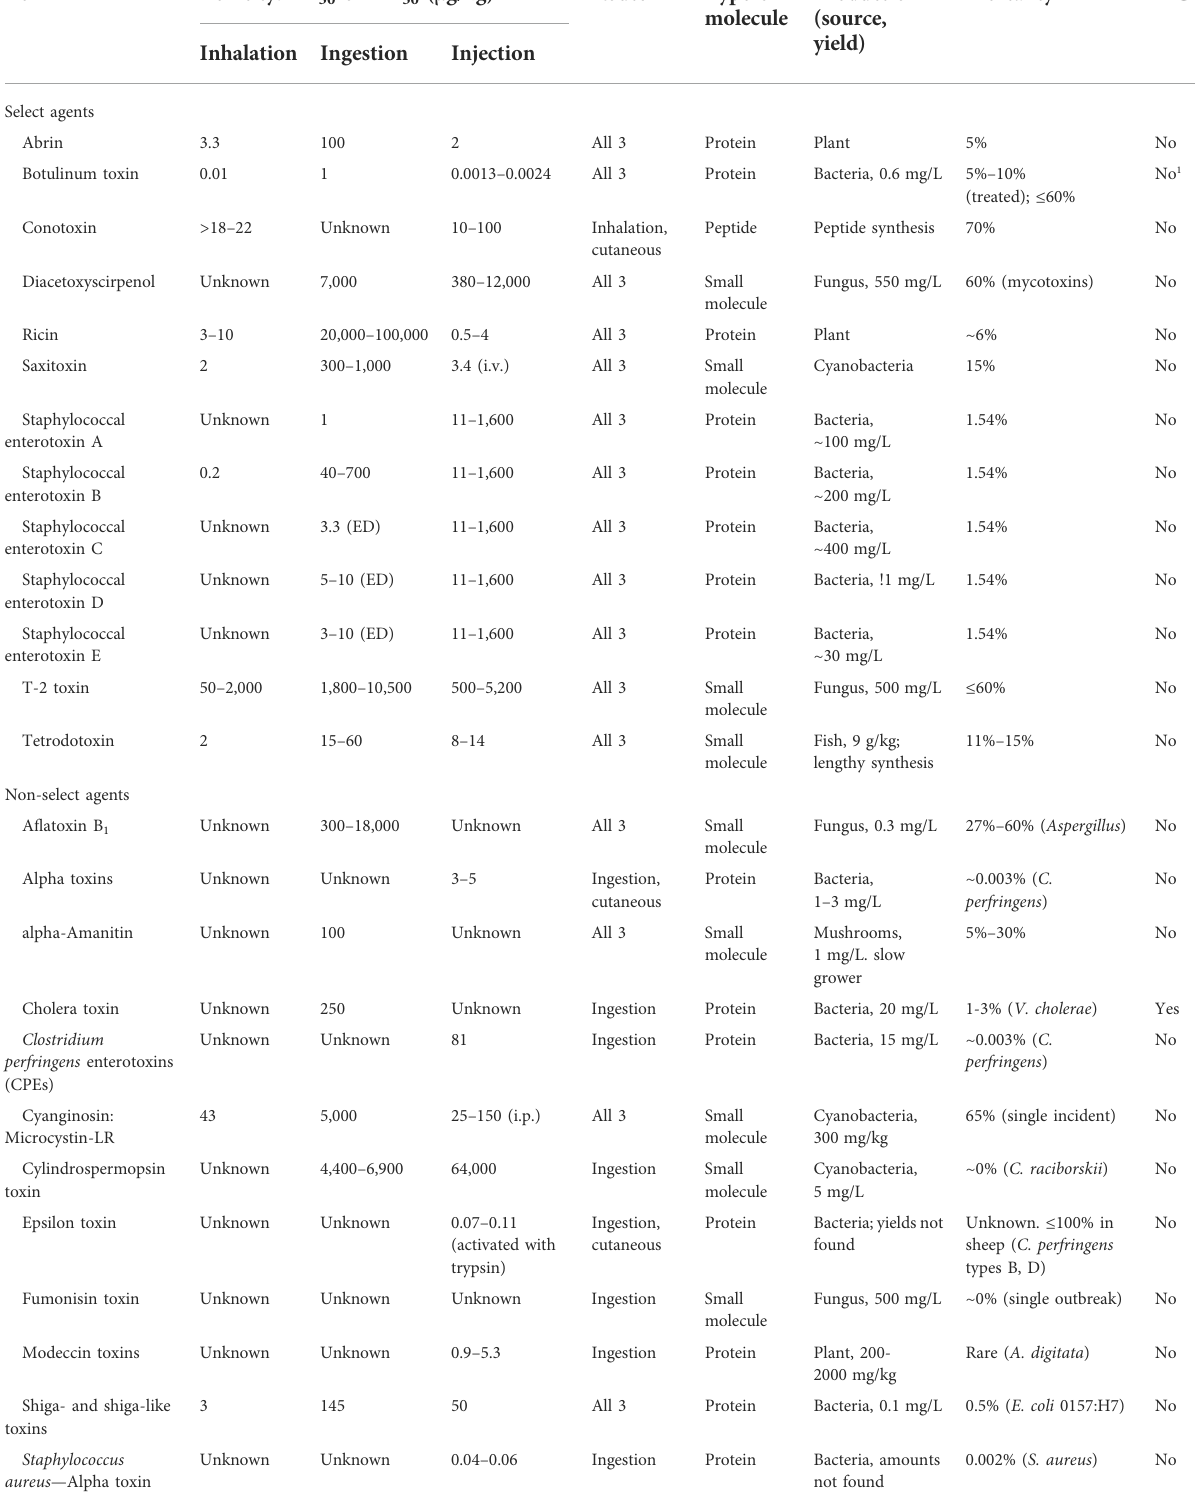
TABLE 3 Summary of data used to support DSF analysis. Toxicity, route, stability, production, mortality, and availability of medical countermeasures data for 30 evaluated toxins (See Supplemental Reference List for